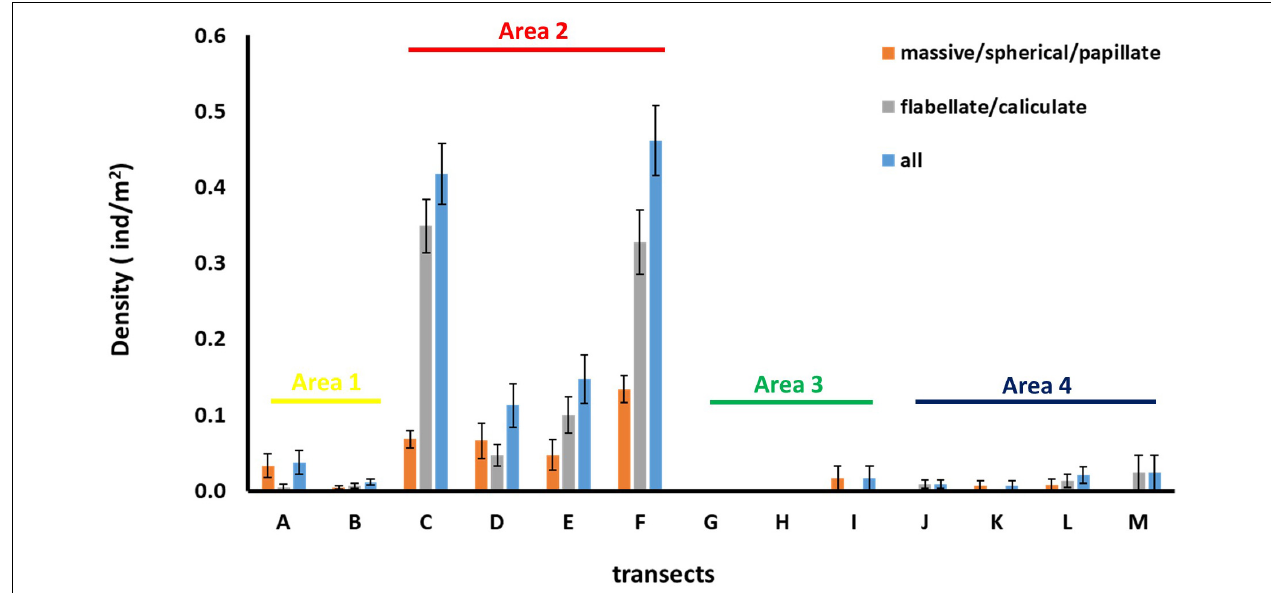
FIGURE 6 | Average ± standard error values of sponge density for each of the sponge morphotype categories across the thirteen transects.